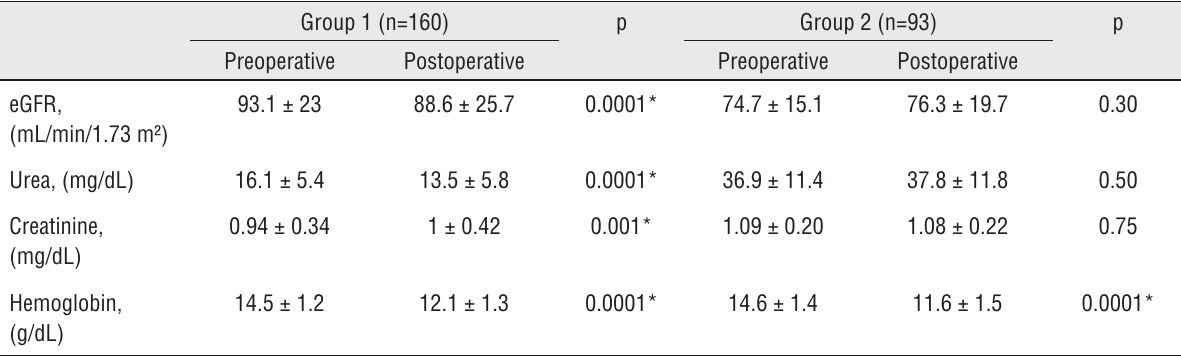
Table 3 - Intragroup comparison of eGFR, urea, creatinine levels and hemoglobin between preoperative and postoperative early periods (paired samples